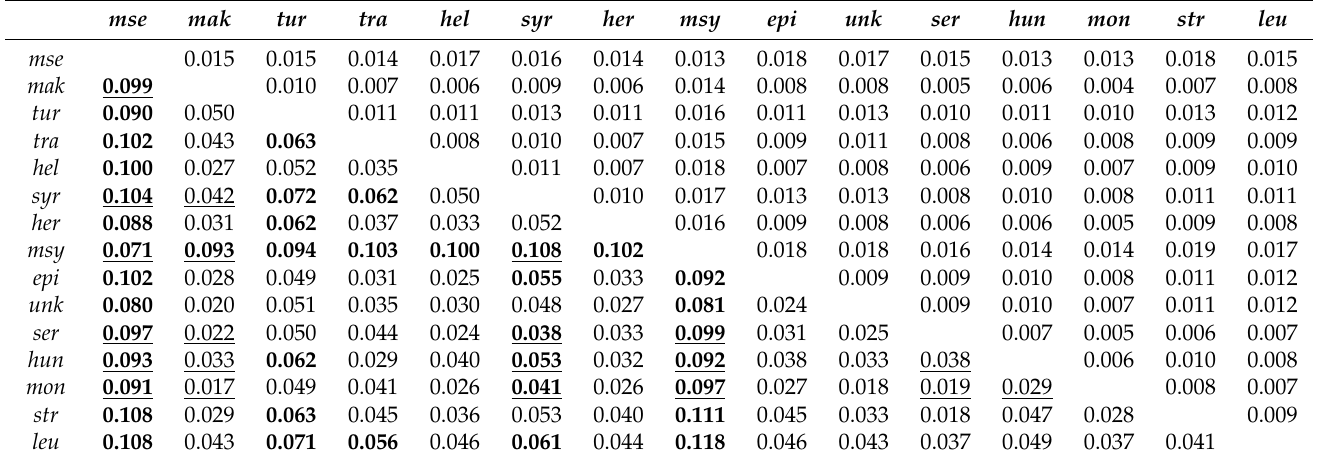
Table 4. Estimates of evolutionary divergence over sequence pairs between N. leucodon CFs inferred from the MT-CYTB dataset. Standard error estimates are shown above the diagonal. See Figure 1 for abbreviations of